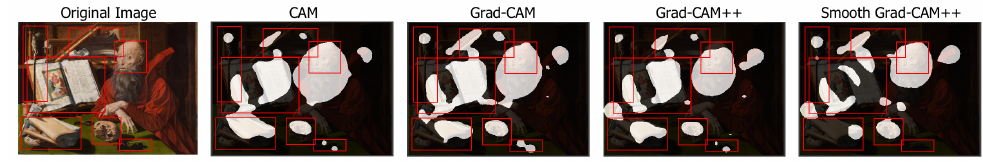
Figure 13. Class activation maps with seven recognized symbols associated with Saint